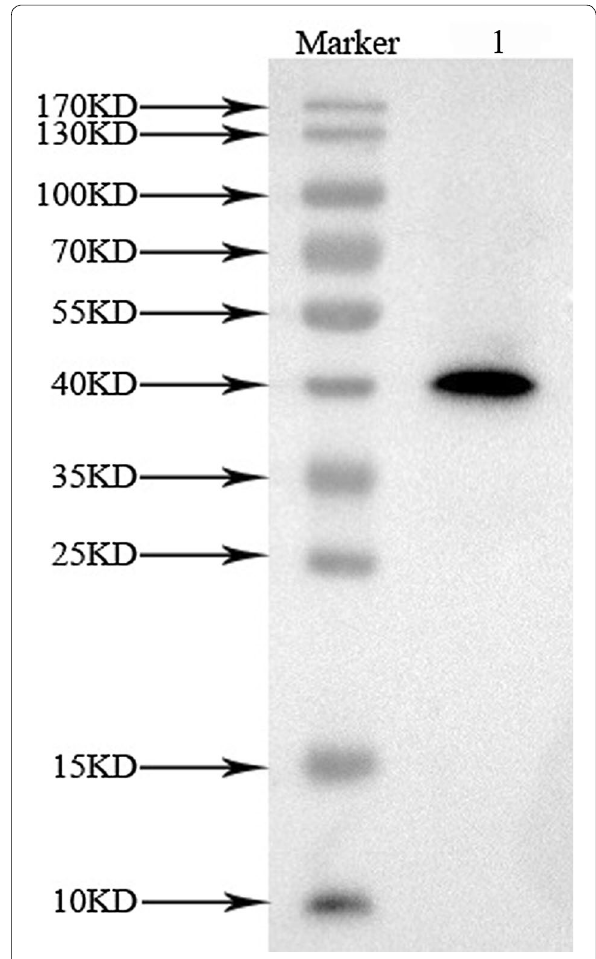
Fig. 7 Immunoblot analysis with EhAACT antibody. Lane 1: marker; Lane 2: the corresponding protein gel blot probed with affinity- purified anti-EhAACT